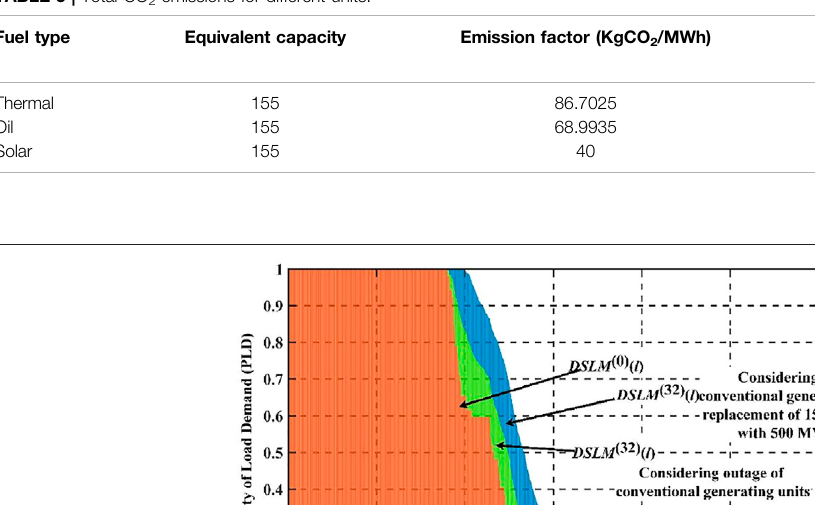
TABLE 5 | Total CO 2 emissions for different units.